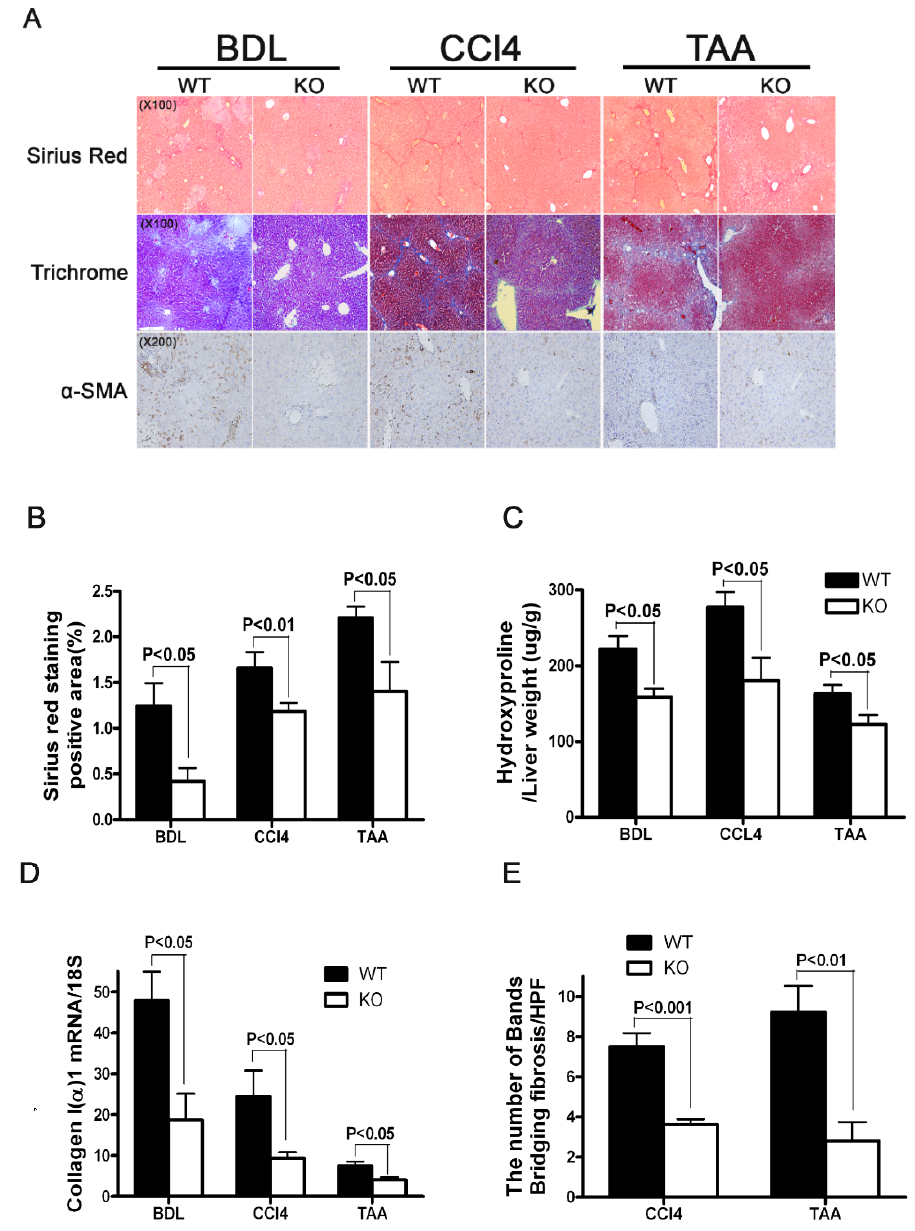
Figure 2. Liver fibrosis is decreased in SULF2-KO mice. ( A ) Histological analysis of livers from WT and SULF2-KO mice shows hepatic fibrosis and HSC activation. Livers were harvested, fixed in formalin, and stained for collagen content with Sirius red and Masson trichrome and for the analysis of HSC activation with α -SMA. ( B ) Positive areas stained with Sirius red were quantitated using digital image analysis. Representative photomicrographs of liver sections are depicted (100 × magnification). ( C ) Collagen content of WT and SULF2-KO mouse livers. ( D ) The mRNA levels of collagen I( α )1 in mice with liver fibrosis. ( E ) The number of bridging fibrosis in Sirius red staining. Bridging